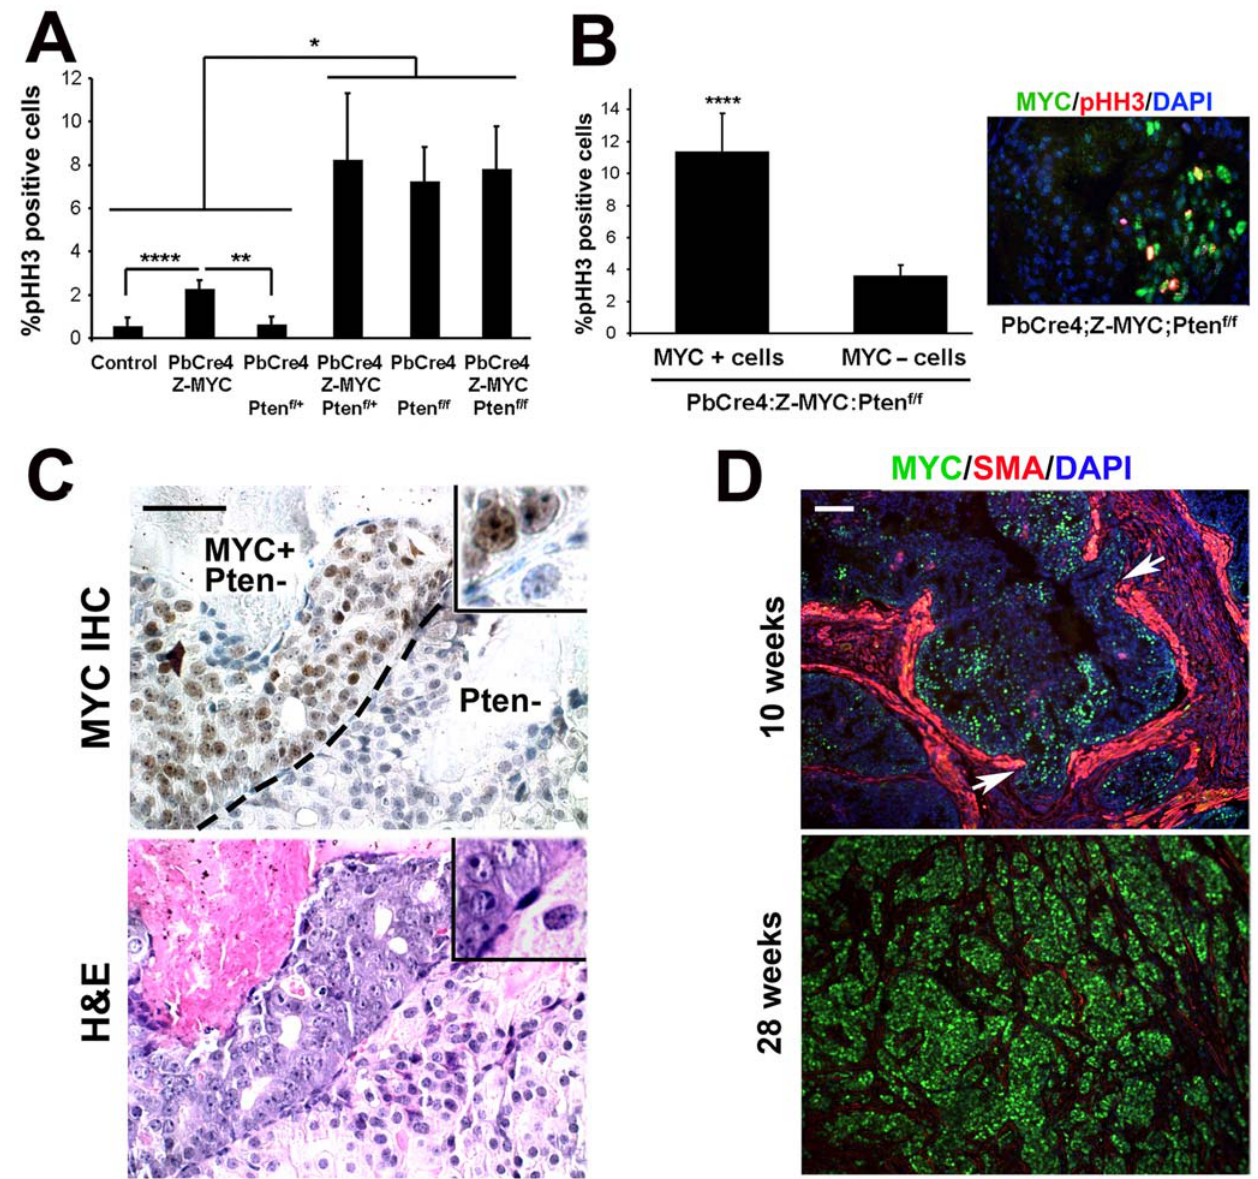
Figure 5. c-MYC expression increases the proliferation and tumorigenicity of Pten -deficient cells. (A) Proliferation was determined by analysis of phospho-histone H3 staining. (B) Phospho-histone H3 index in c-MYC-positive or c-MYC-negative cells in PbCre4;Z-MYC;Pten f/f prostates. Inset: double staining shows colocalization of phospho-histone H3 with c-MYC in PbCre4;Z-MYC;Pten f/f prostate. N=3–4 mice per group. * p , 0.05, ** p , 0.005, **** p , 0.01. (C) c-MYC staining identifies MYC-expressing cells next to MYC-negative cells in the same gland of PbCre4;Z-MYC;Pten f/f mouse prostate. An adjacent H&E-stained section is also shown. Note distinct, higher grade pathology of c-MYC + cells. Scale bar: 50 m m. (D) c- MYC + ;Pten -null cells outcompete Pten -null cells. Prostates from 10-week-old and 28-week-old PbCre4;Z-MYC;Pten f/f mice were stained for c-MYC and smooth muscle actin. At 10 weeks, c-MYC expression is focal; at 28 weeks, it is uniform. Arrows indicate discontinuity of smooth muscle actin (focal micro-invasion). Scale bar: 100 m